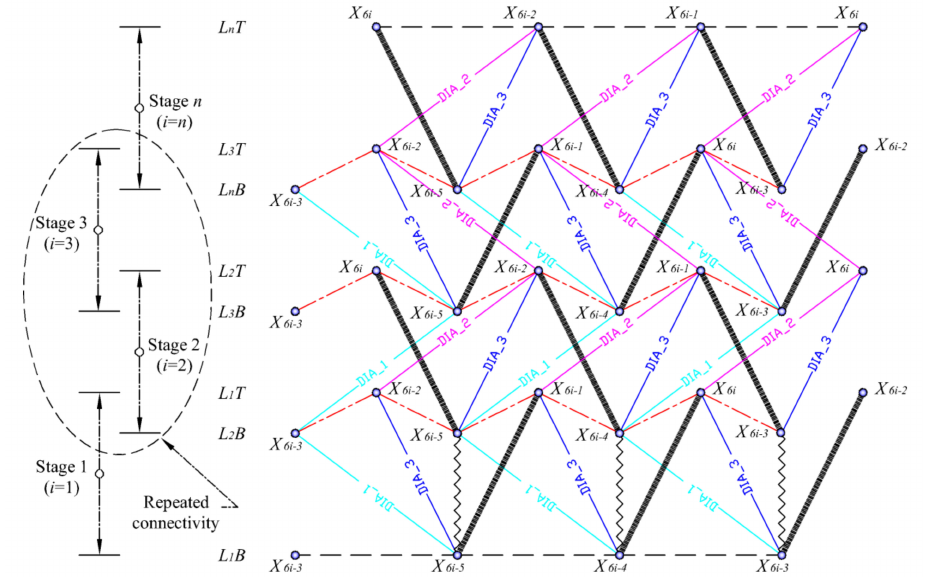
Figure 6. Element connectivity of N -stage class one three-strut spine biotensegrity